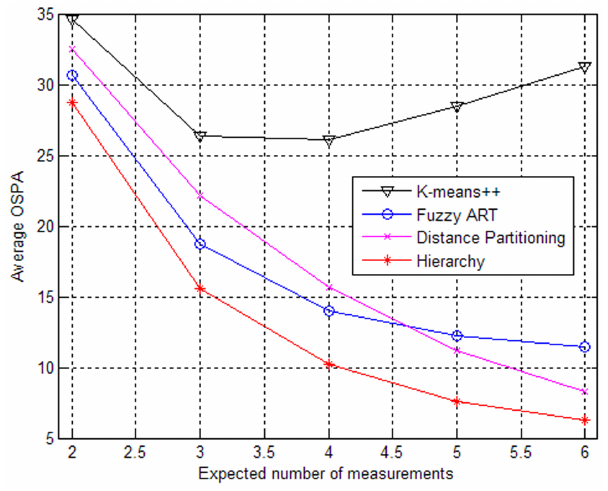
Figure 2. Performances of partitioning algorithms versus expected number of measurements.